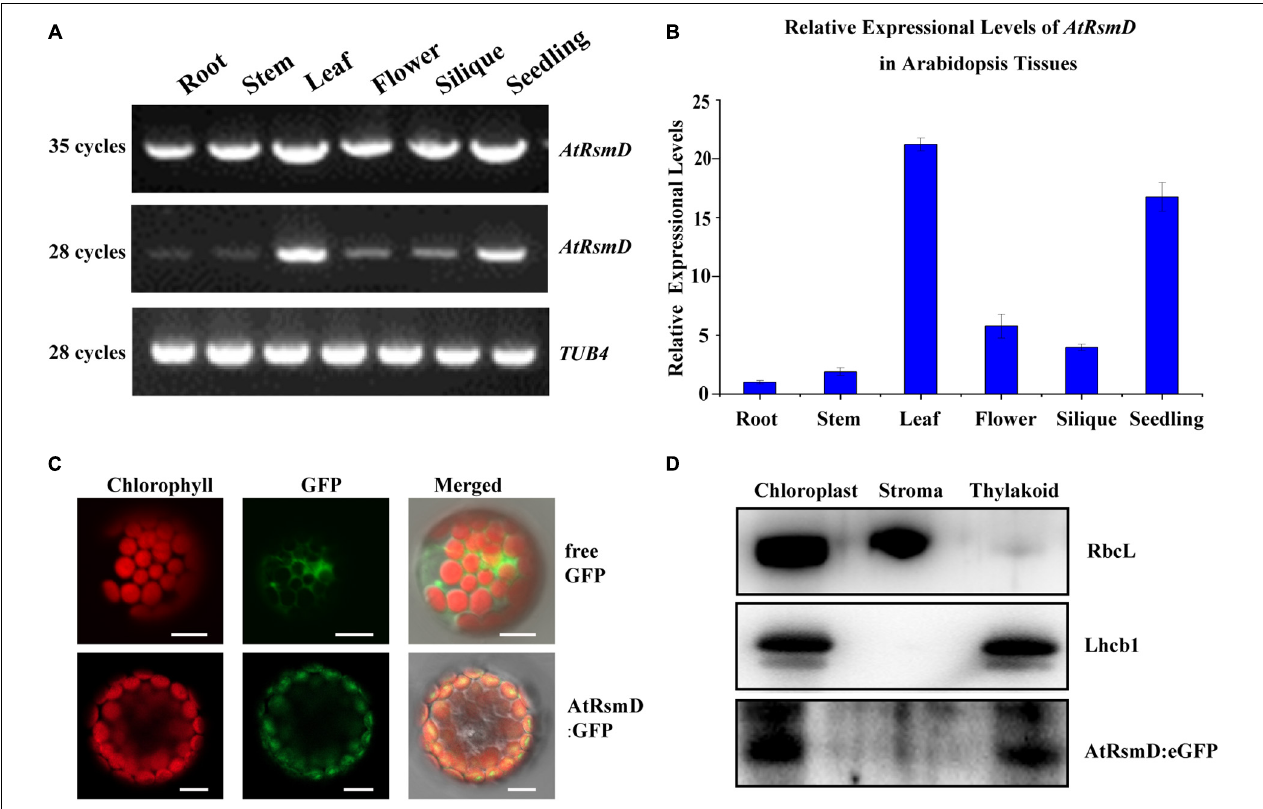
FIGURE 2 | Expression pattern of the AtRsmD gene and subcellular localization of its product in Arabidopsis. (A) Semi-RT–PCR and (B) RT–qPCR analysis of AtRsmD mRNA in different Arabidopsis tissues and organs, including roots, stems, leaves, flowers, siliques and seedlings. Tubulin 4 was used as a control. (C) Localization of the AtRsmD:eGFP fusion protein in Arabidopsis protoplasts. Free eGFP in Arabidopsis protoplasts was used as a control. Green fluorescence shows eGFP fluorescence, red fluorescence indicates chloroplast autofluorescence, and orange/yellow fluorescence shows overlapping images of the two types of fluorescence. Scale bars: 5 µ m. (D) The AtRsmD:eGFP protein is associated with thylakoid membranes in chloroplasts. The fractionation of Arabidopsis seedling chloroplasts was performed with anti-GFP, anti-Lhcb1, and anti-RbcL